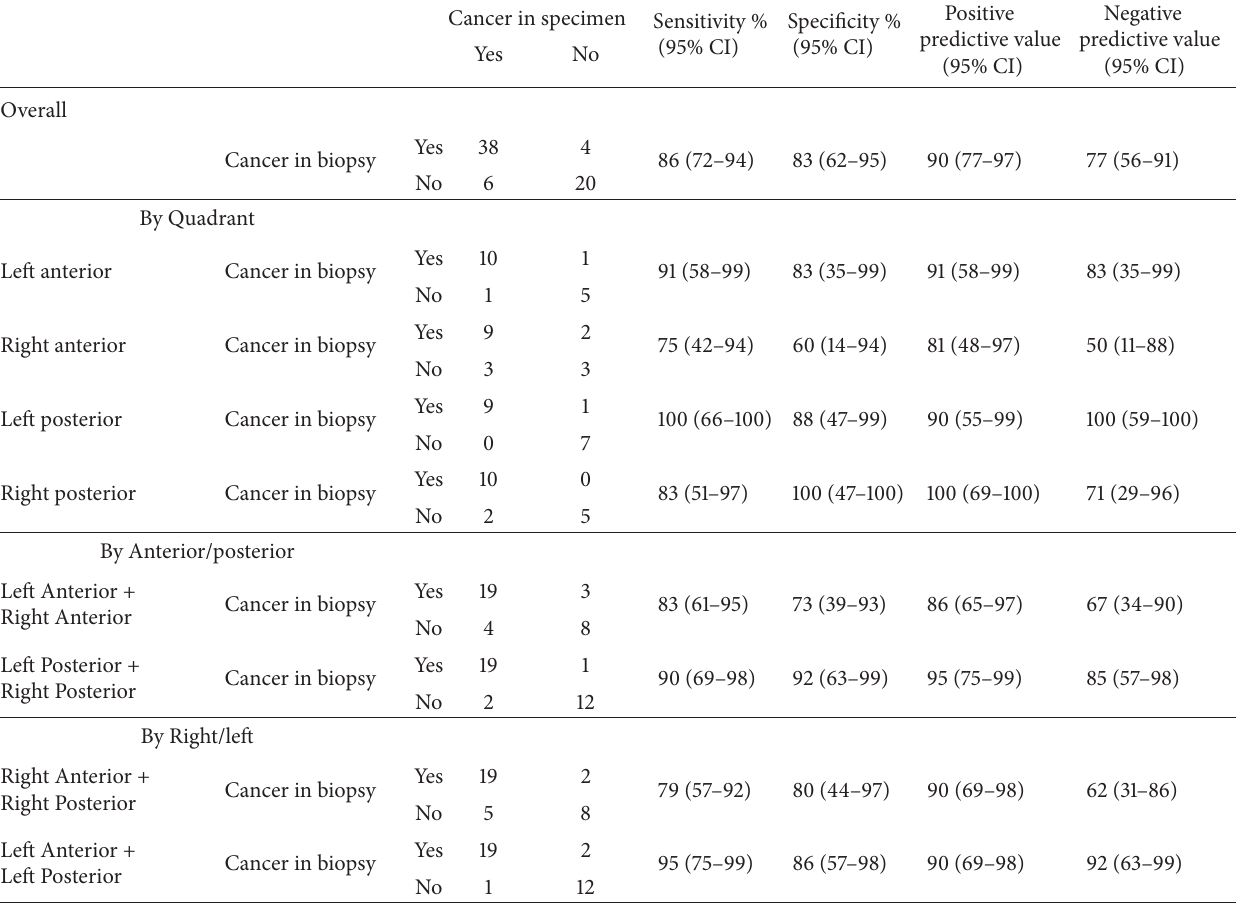
Table 4: Sensitivity and specificity of TMB for detection of prostate cancer, overall and separately by quadrant, using RP specimen pathology as gold